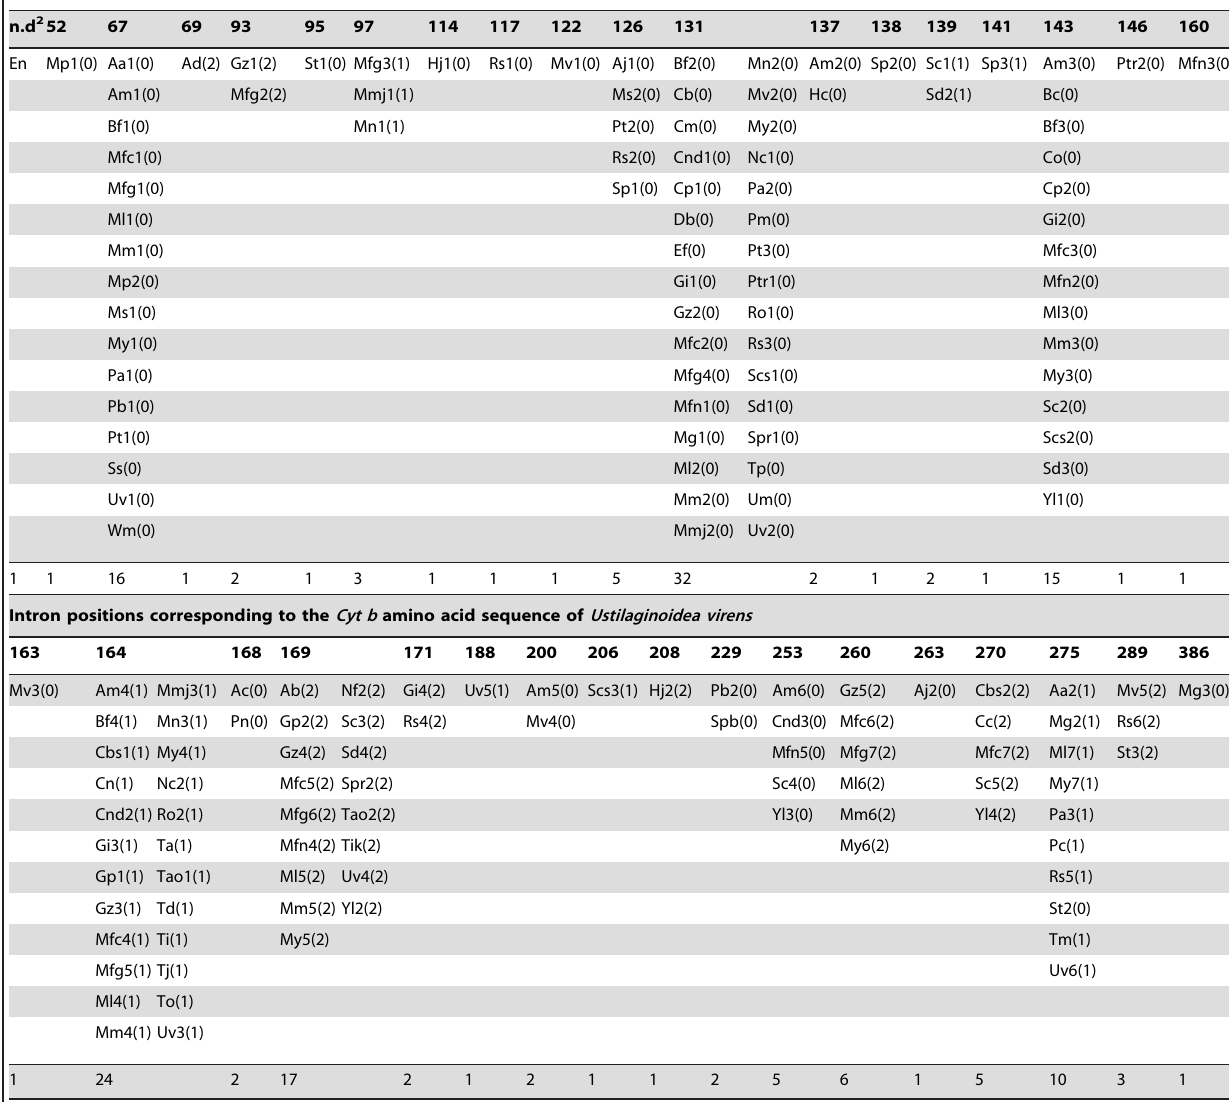
Intron locations corresponding to the Cytb amino acid sequence of Ustilaginoideavirens